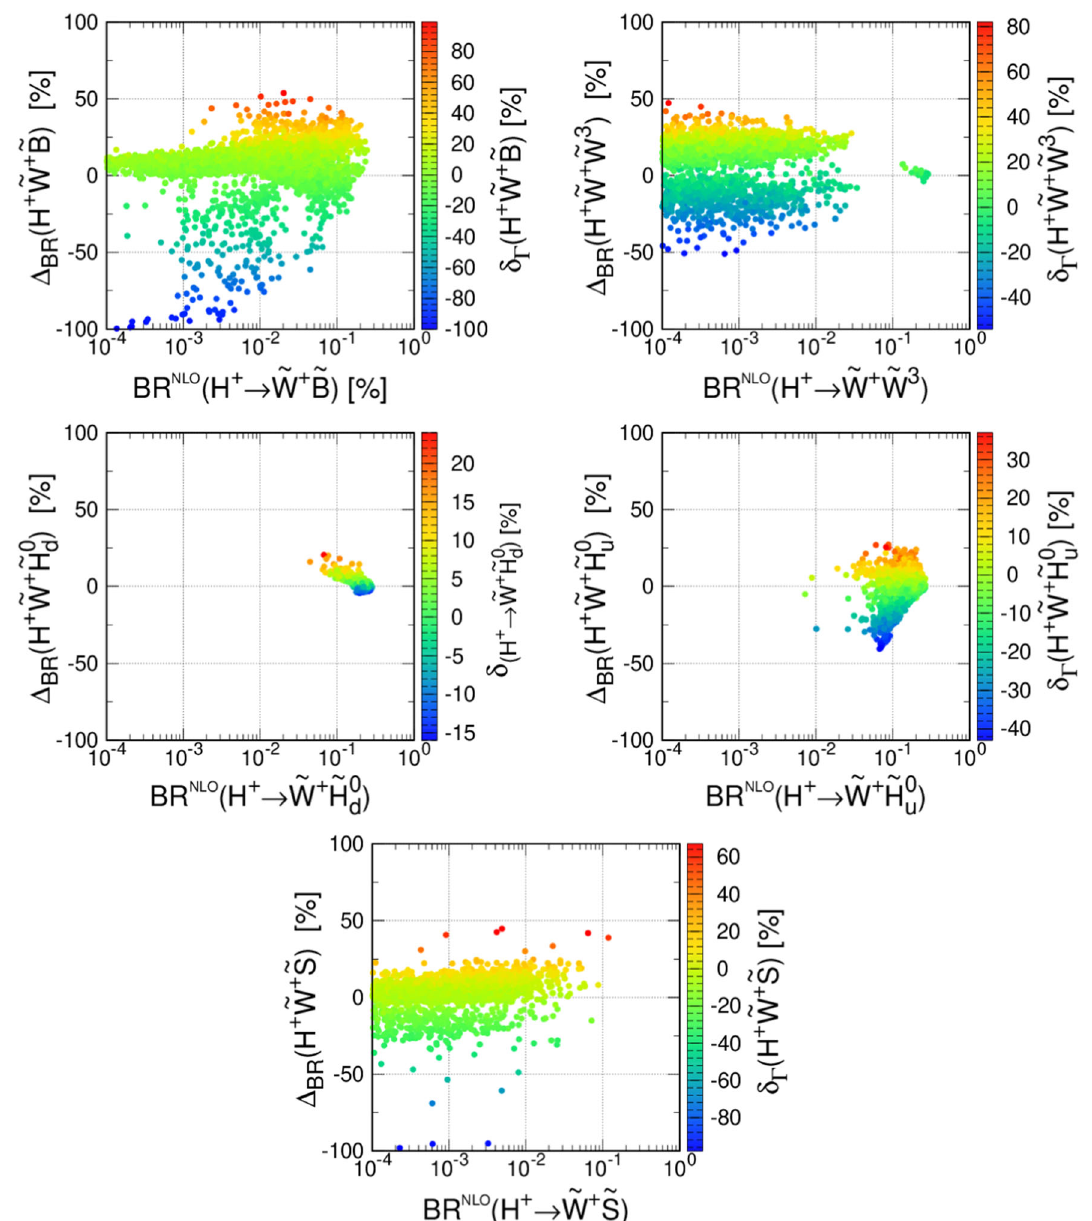
Fig. 4 Relative change in the branching ratio as defined in Eq. (135) for the H + decay into into charged wino plus neutral electroweakino final states all in the gauge basis as a function of the respective SUSY-